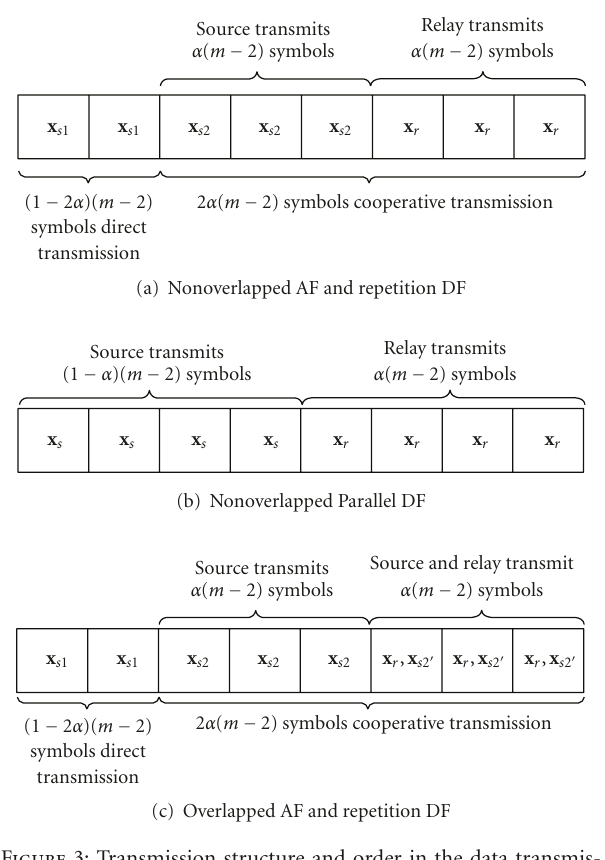
Figure 3: Transmission structure and order in the data transmis- sion phase for di ff erent cooperation